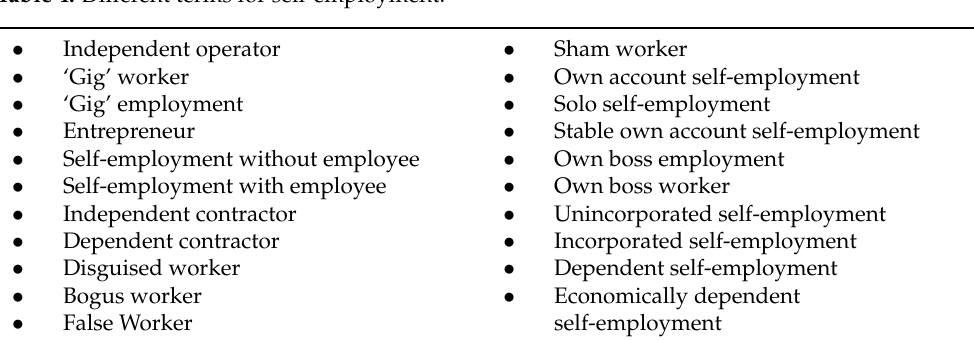
Table 4. Different terms for